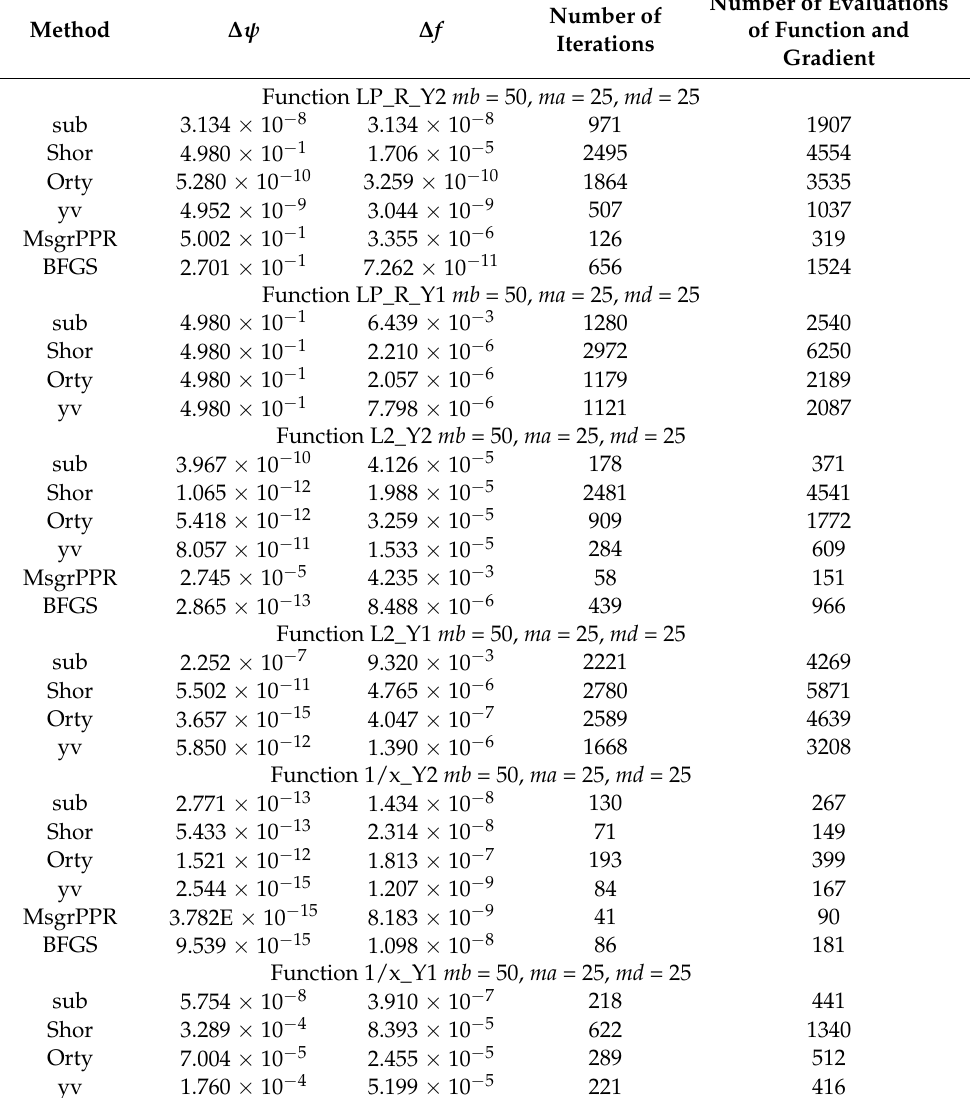
Table 7. Results of calculations for dimensions n = 10,000, m = 250 with mb = 50.